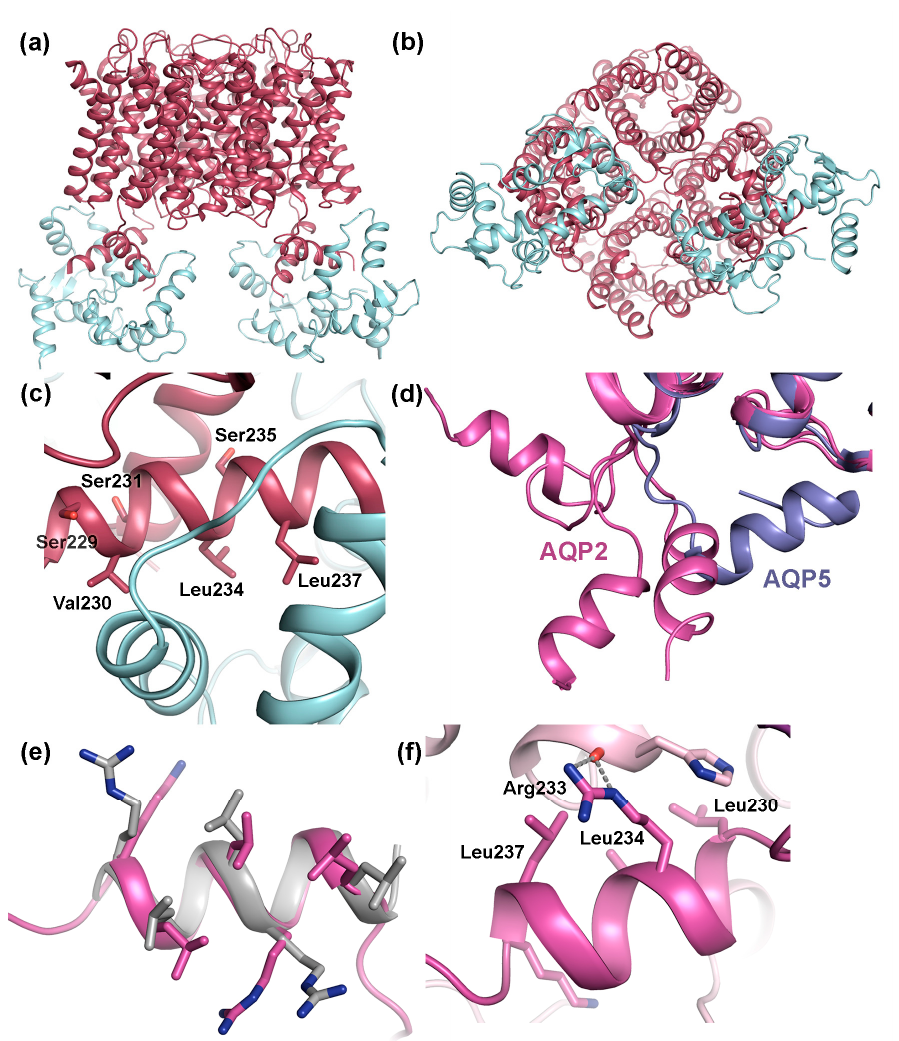
Figure 7. Transient interactions between mammalian AQPs and regulatory proteins. Pseudo-atomic model of the complex between AQP0 (dark red) and calmodulin (CaM, licht cyan) (PDB code 3J41) viewed: ( a ) parallel to the membrane; and ( b ) from the cytoplasmic side showing how one CaM-molecule binds the C-terminal helix from two AQP0 monomers. ( c ) Close-up of the AQP0-CaM interaction site showing three hydrophobic residues that are important for binding (Val230, Leu234, Leu237) as well as nearby phosphorylation sites (Ser229, Ser231, Ser235). ( d ) Crystal structure of human AQP2 (pink, PDB code 4NEF) showing how the C-terminal helix of the four overlaid AQP2 monomers adopts different conformations, neither of which correspond to the conformation seen in other mammalian AQPs, here illustrated by the crystal structure of human AQP5 (purple, PDB code 3D9S). ( e ) Overlay of the AQP2 C-terminal helix and the LYST-interacting protein 5 (LIP5) interaction site in charged multivesicular body protein 1B (CHMP1B) (grey, PDB code 4TXQ) showing how the MIT-interacting motifs (MIM) perfectly overlap structurally. ( f ) Close-up of AQP2 crystal contacts showing how the AQP2 MIM mediates interactions between symmetry-related molecules. Calmodulin Inhibits AQP0 Water Permeability through an Allosteric Mechanism Analysis of the pore dimensions in the AQP0-CaM model showed that, although CaM binds directly below two of the AQP0 monomers in the tetramer, the channel remains open and is accessible